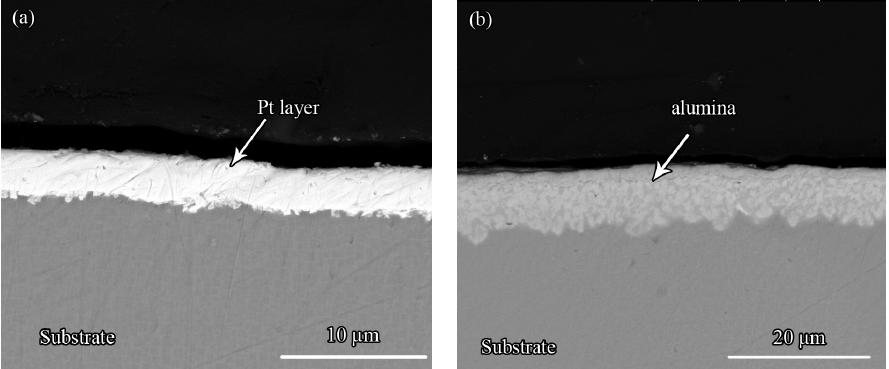
Figure 1. The cross-sectional morphologies of the electroplated Pt coating: ( a ) before treatment at 1080 °C for 2 h; ( b ) after heat treatment at 1080 °C for 2 h.